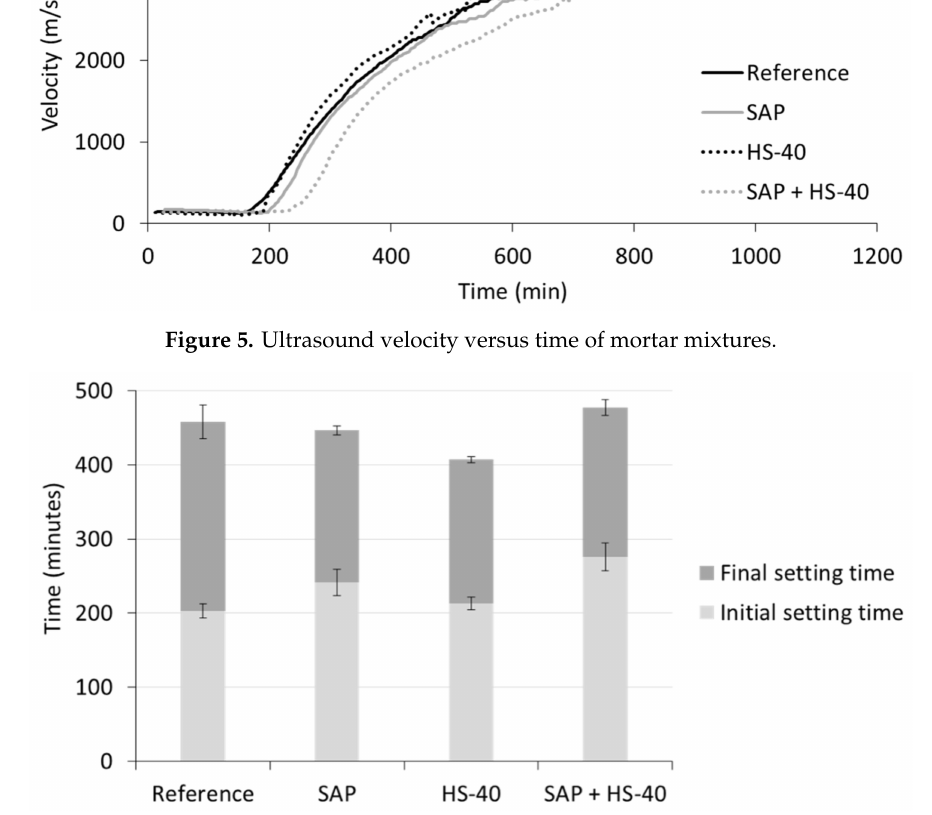
Figure 6. Initial and final setting by ultrasound measurements of mortar